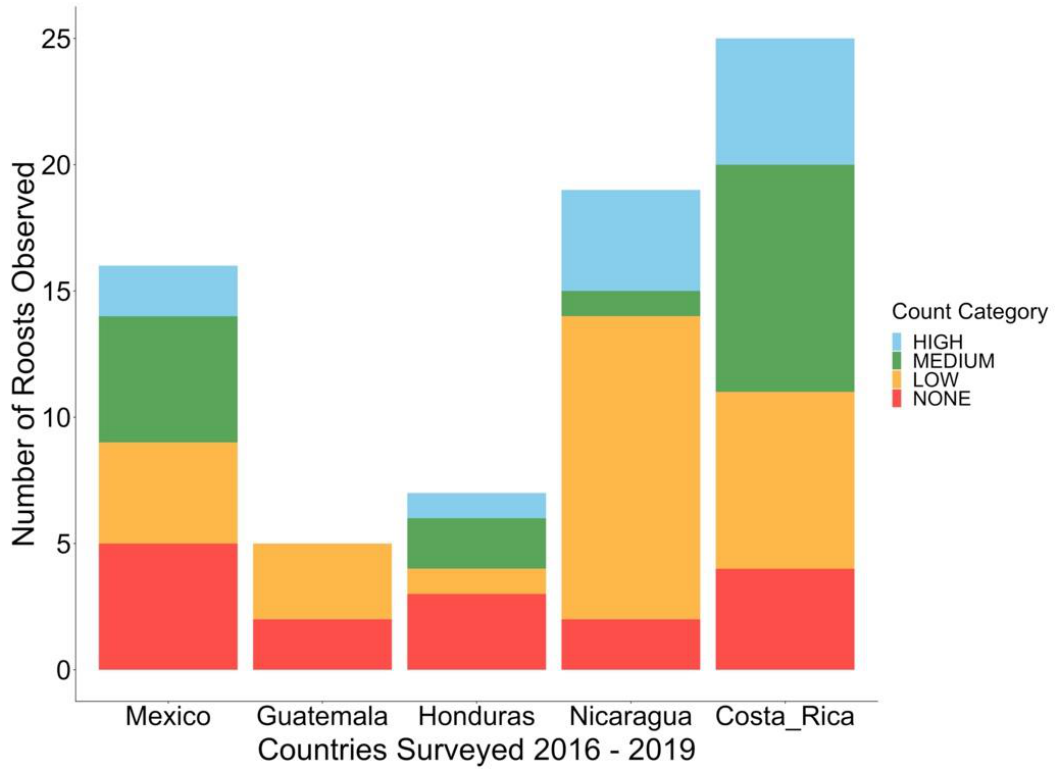
Figure 2. The number of none, low, medium, and high roosts in each country. Roosts were assigned a count category based on the number of birds present. None = 0 birds counted at the roost, low = 1–20 birds, medium = 21–50 birds, and high = 51+ birds.